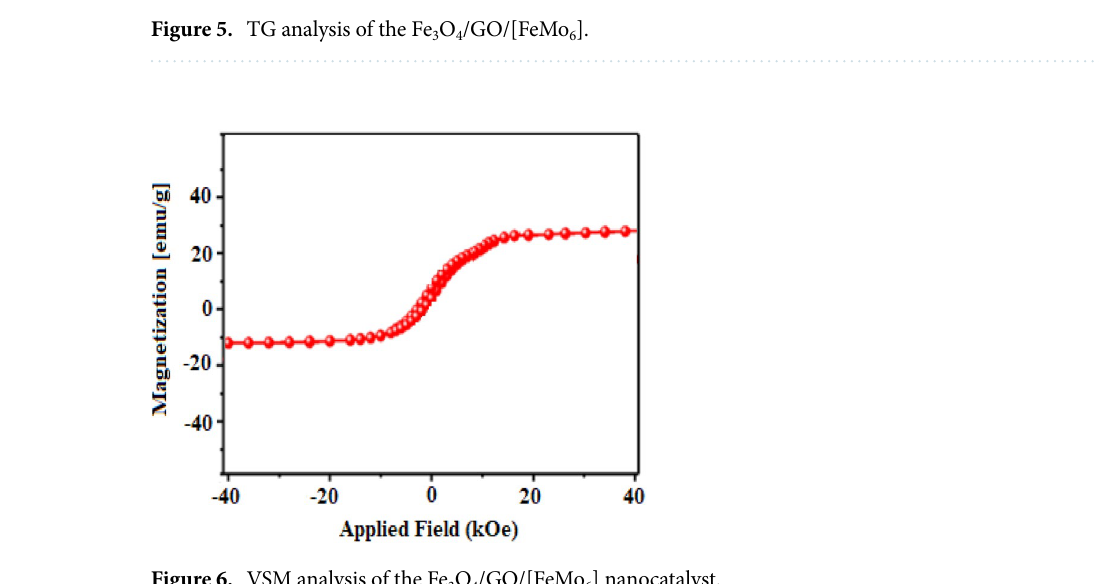
Figure 6. VSM analysis of the Fe 3 O 4 /GO/[FeMo 6 ]